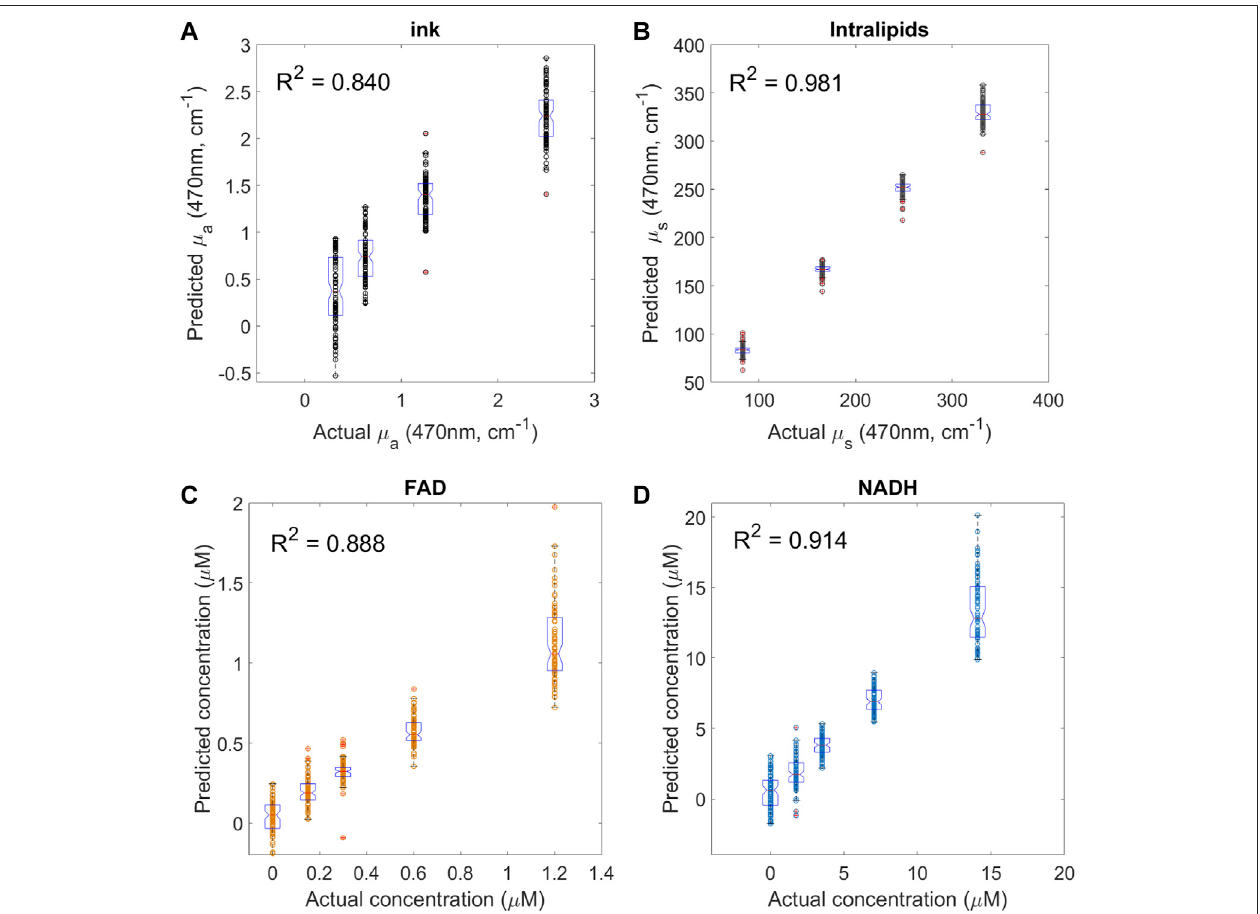
FIGURE 7 | System validation using mixture of fl uorophores in liquid phantoms with various optical properties. Each graph shows the prediction values versus actual values for (A) absorption coef fi cient using different ink volume fraction ( n (cid:1) 100 for each group), (B) scattering coef fi cient using different intralipids volume fraction ( n (cid:1) 100 for each group), (C) FAD ( n (cid:1) 80 for different FAD concentration group), and (D) NADH ( n (cid:1) 80 for different NADH concentration group). R2 is the correlation coef fi cient between the fi tted responses (predicted values) and actual values using PLS regression with leave-one-out cross validation. Boxplots indicate the median value and data distribution in each